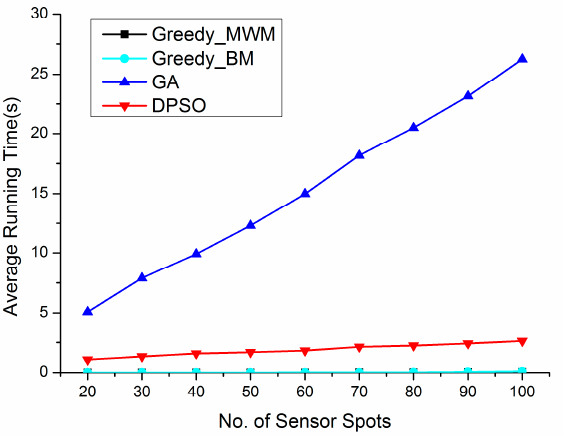
Figure 10. Average running time of the greedy algorithms, GA, and DPSO algorithm.